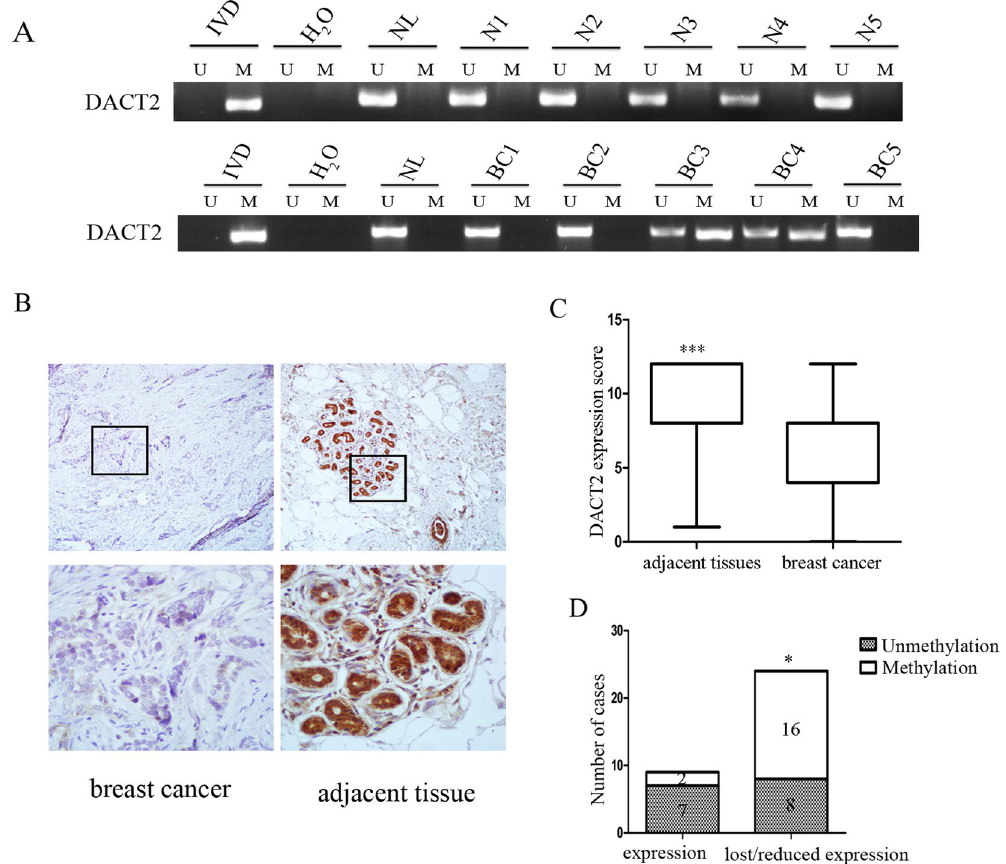
Figure 2. Representative MSP and IHC results of DACT2 in human primary breast cancer ( A ) Representative MSP results of DACT2 in normal breast tissues (N1, N2, N3, N4 and N5) and primary breast cancer tissues (BC). ( B ) Representative IHC staining of DACT2 in breast cancer (left panels) and adjacent tissue (right panels). Upper panels: 100 × ; lower panels: 400 × . ( C ) DACT2 expression scores are shown as box plots. The bottom and top of the boxes represent the 25th and 75th percentiles, respectively; vertical bars represent the range of data. The levels of expression are higher in adjacent tissue compared to cancer samples. *** P < 0.001 ( D ) The levels of DACT2 expression and DNA methylation status are shown as bar diagram. Reduced expression of DACT2 was significantly associated with promoter region hypermethylation. * P <